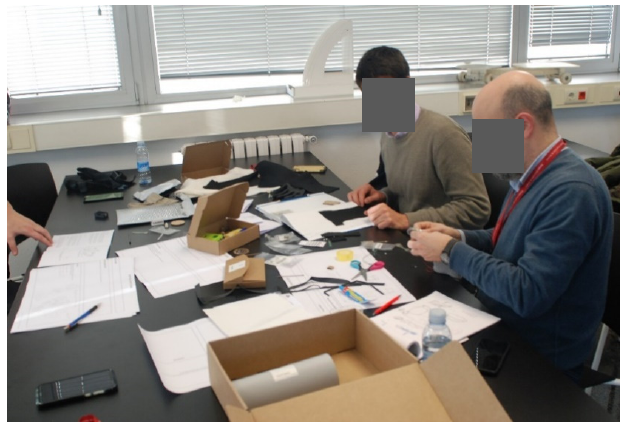
Figure 17. Participants from Group 1 making the physical prototype.